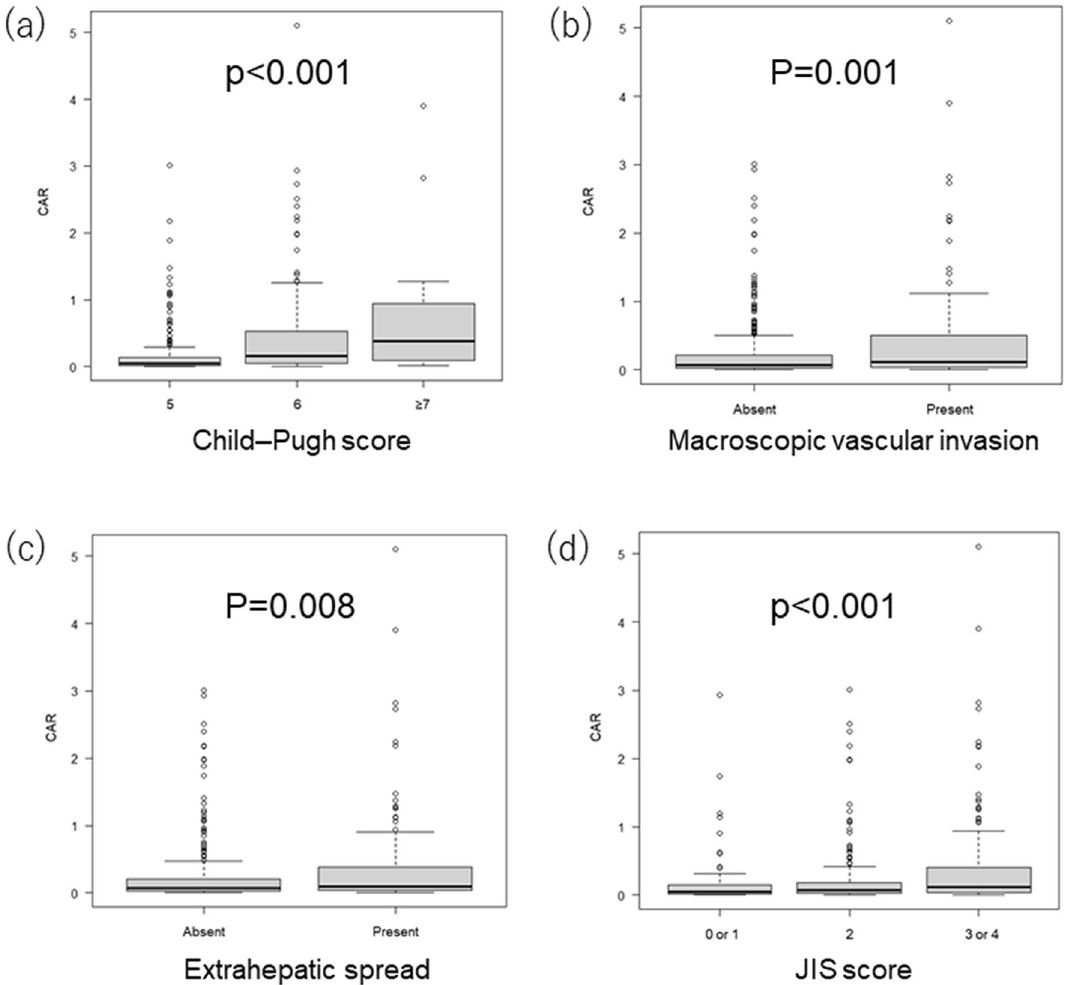
Figure 4. Relationship between clinical markers and CAR. ( a ) Relationship between Child–Pugh score and CAR. CAR values were 0.049 (0.020–0.136), 0.160 (0.047–0.527), and 0.381 (0.133–0.922) in patients with Child–Pugh score of 5 (n = 302), 6 (n = 206), and ≥ 7 (n = 14), respectively ( p < 0.001, Jonckheere-Terpstra test). ( b ) Relationship between the presence or absence of macroscopic vascular invasion and CAR. CAR values were 0.074 (0.025–0.222) and 0.120 (0.038–0.505) in patients with (n = 407) and without (n = 115) macroscopic vascular invasion, respectively ( p = 0.001, Mann–Whitney U-test). ( c ) Relationship between the presence or absence of extrahepatic spread and CAR. CAR values were 0.072 (0.025–0.209) and 0.097 (0.036–0.384) in patients with (n = 330) and without (n = 192) extrahepatic spread, respectively ( p = 0.008, Mann–Whitney U-test). ( d ) Relationship between JIS score and CAR. CAR values were 0.045 (0.015–0.152), 0.074 (0.026– 0.188), and 0.116 (0.036–0.409) in patients with JIS score of 0 or 1 (n = 93), 2 (n = 197), and 3 or 4 (n = 232), respectively ( p < 0.001, Jonckheere-Terpstra test). The box represents the interquartile range. The line through the box indicates the median. The bottom error bar indicates the 25th percentile − 1.5 × interquartile range and the top error bar indicates the 75th percentile + 1.5 × interquartile range. CAR, C-reactive protein to albumin ratio; JIS, Japan Integrated